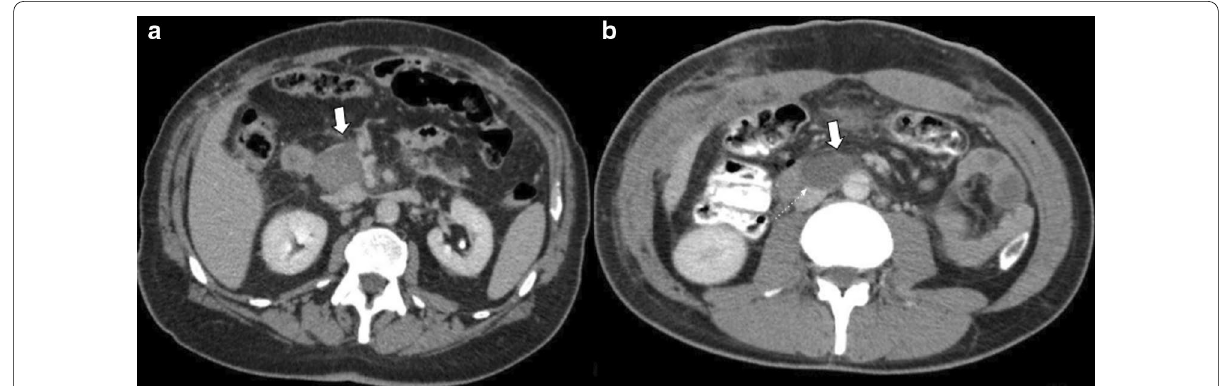
Fig. 17 Pancreatic fistula vs. Abscess. Two different patients. Axial portal venous phase CT scans: ( a ) 73-year-old male patient with abdominal pain 25 days after pancreaticoduodenectomy due to pancreatic neuroendocrine tumor. ( b ) 45-year-old male patient with fever 21 days after pancreaticoduodenectomy due to ampulloma. Both present an homogeneous fluid collection near the PJ (big arrow). In patient B impresses to exist a thin wall during portal phase (dotted arrow). Both of them were percutaneous drainage with elevated amylase concentration in A and purulent fluid in B.